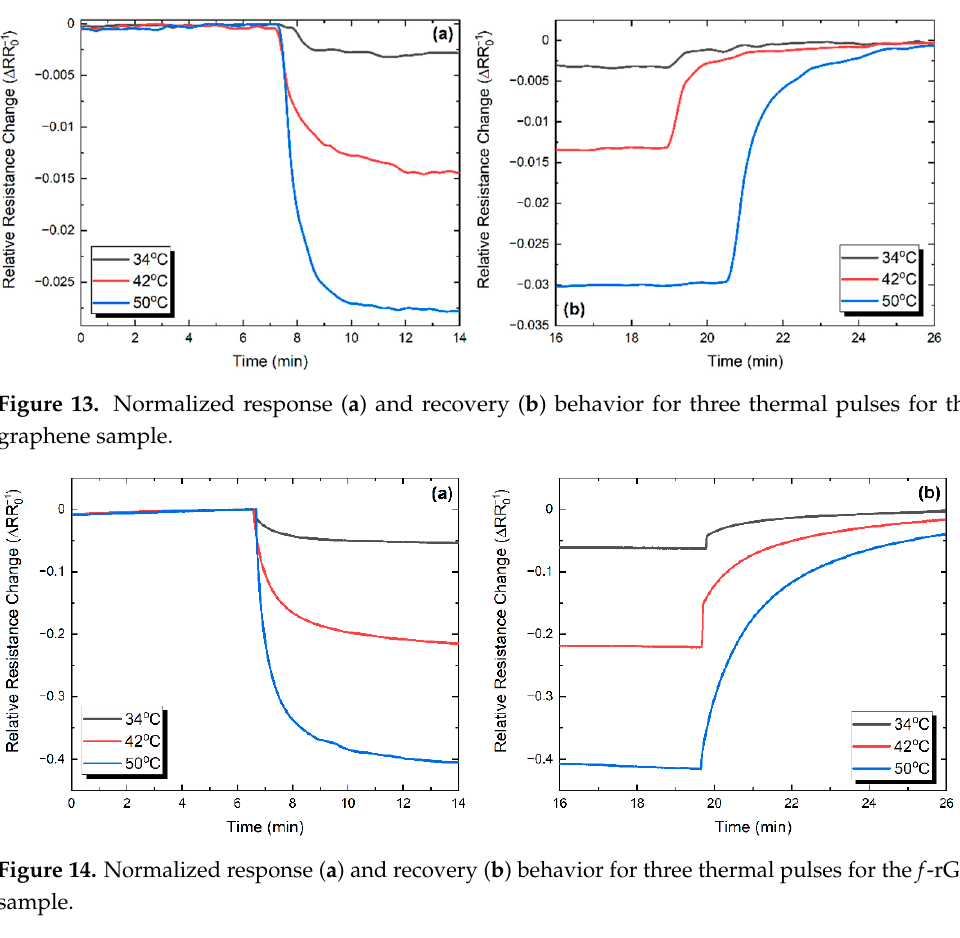
Figure 14. Normalized response ( a ) and recovery ( b ) behavior for three thermal pulses for the f ‐ rGO sample.